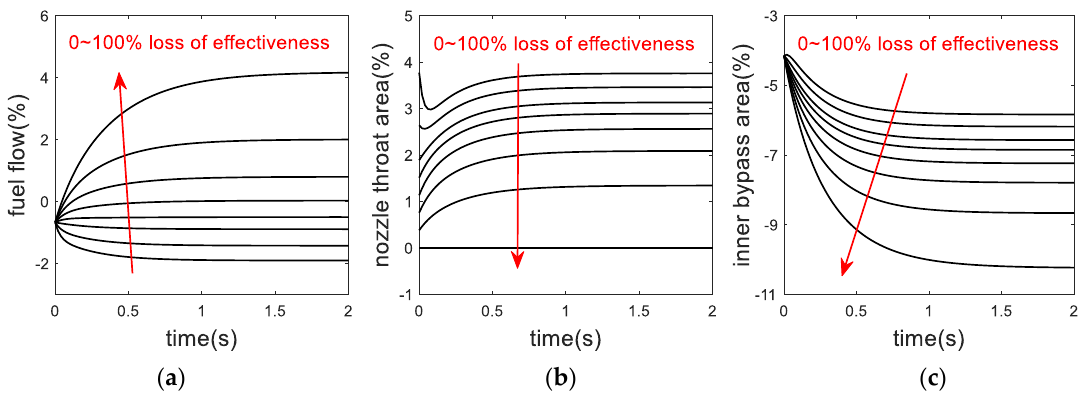
Figure 6. FTC result of SMC design-control variables. ( a ) W f ( b ) A 8 ( c ) A 125 .